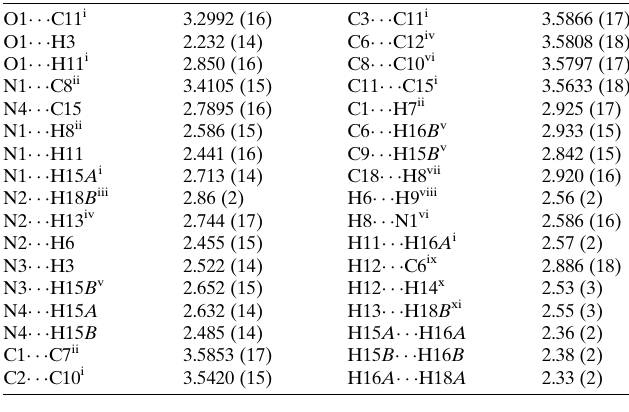
Table 2 Selected interatomic distances (A˚